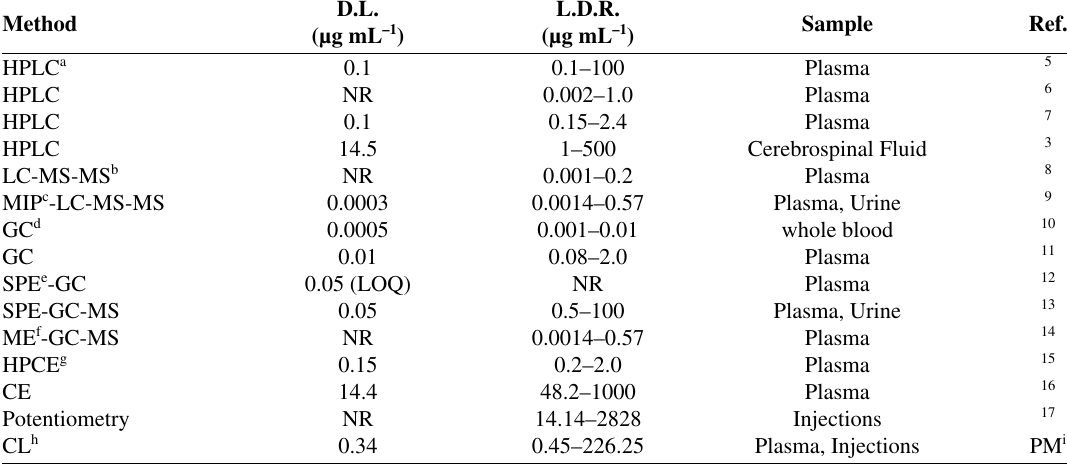
Table 4. Response characteristics of the proposed method in comparison with other methods for the determination of mepivacaine